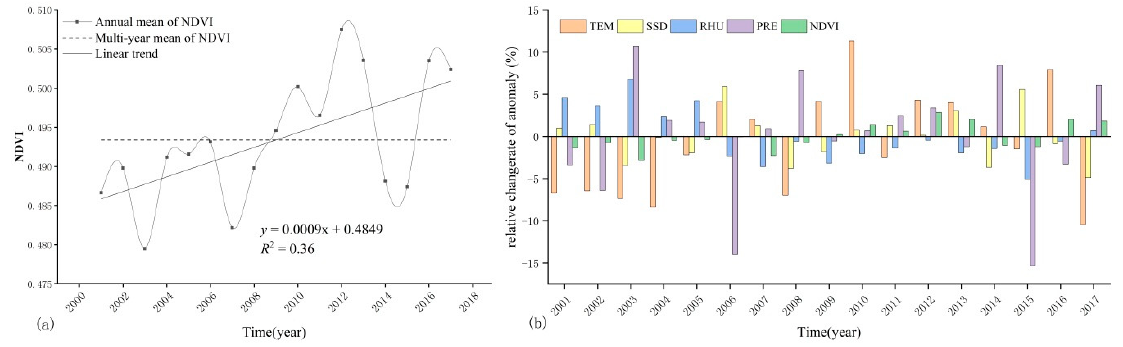
Figure 3. Dynamic changes of NDVI ( a ) and climate factors ( b ) in TP during 2001–2017 (TEM-Air temperature, SSD-sunshine duration, RHU-Relative humidity, PRE-Precipitation).